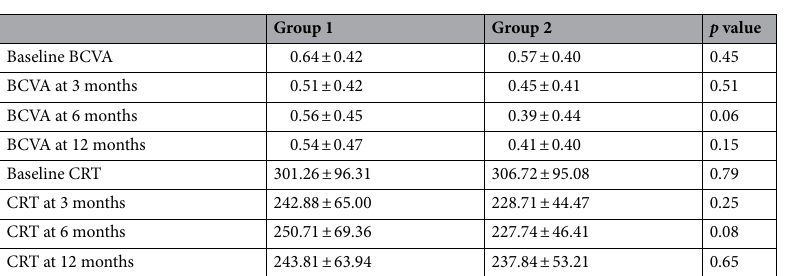
Table 2. Post-treatment effect in different groups. Values are presented as the mean ± standard deviation. Group 1 intravitreal injection of ranibizumab + photodynamic therapy, Group 2 intravitreal injection of aflibercept alone, BCVA best-corrected visual acuity, CRT central retinal thickness.